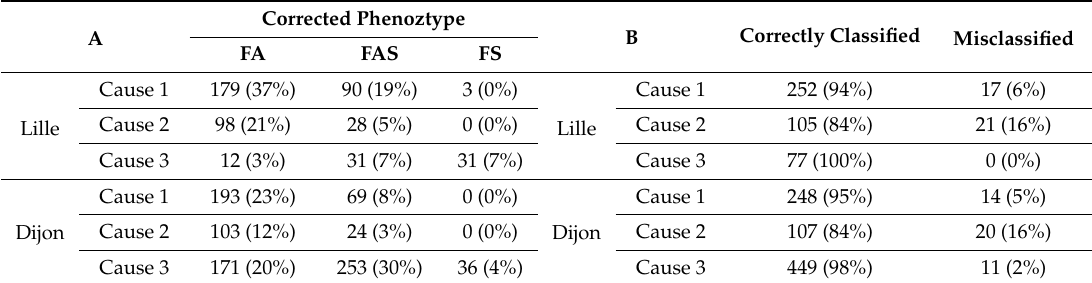
Table 4. (A) Numbers and proportions of nonstandard spectra by corrected phenotype and by cause. (B) Numbers and proportions of correctly classified and misclassified spectra by cause. Cause 1 resulted in spectra with an irregular baseline, cause 2 resulted in spectra with a low, broad peak and cause 3 resulted in spectra with a low resolution. The percentage is based on the number of profiles considered to be nonstandard (780 profiles at Lille and 985 at